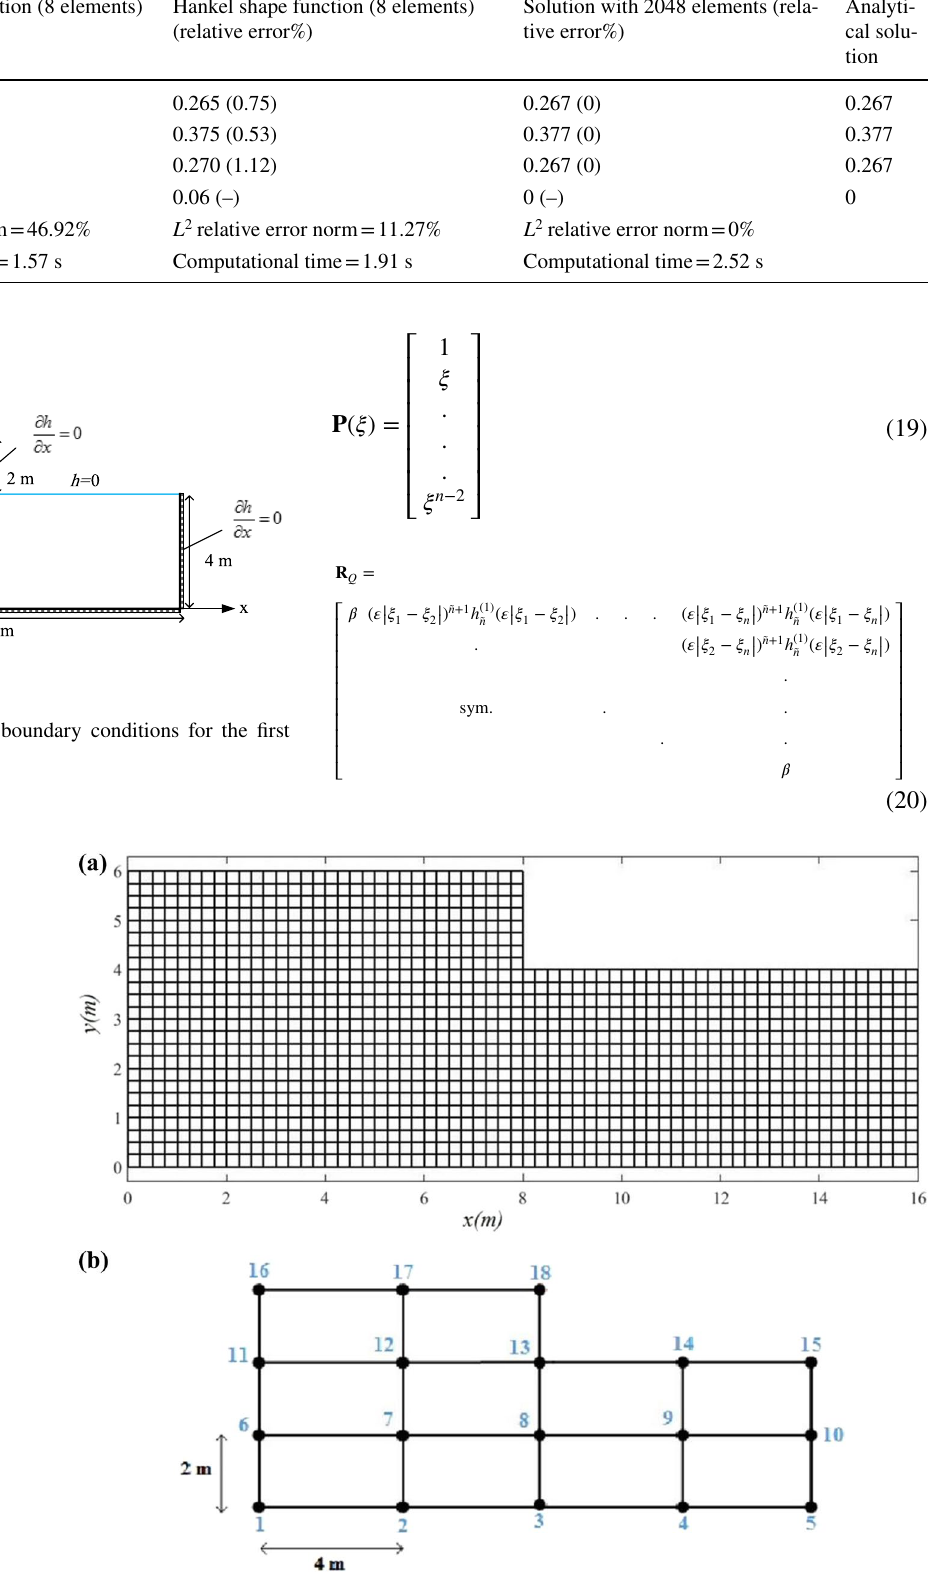
Table 1 Comparison of the results among Hankel shape function (8 elements), Lagrange shape function (8 and 2048 elements) and analytical solution for validation problem Node Lagrange shape function (8 elements) (relative error%)